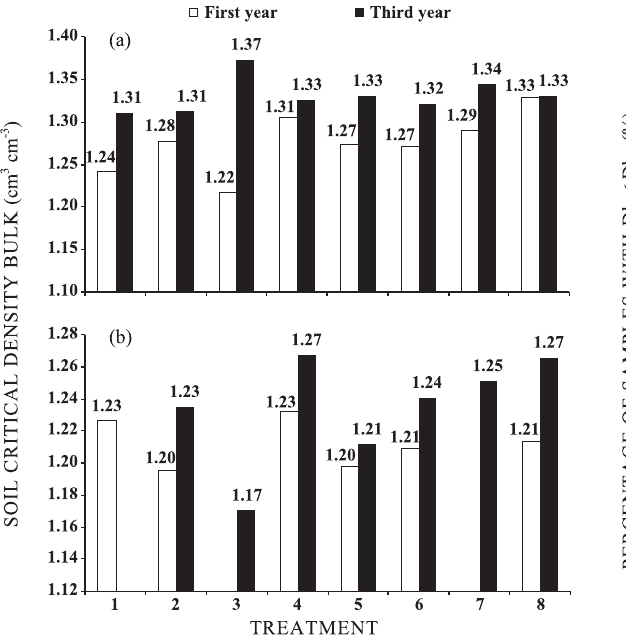
Figure 5. Soil critical bulk densities in the 0–20 (a) and 20–40 cm (b) layers, in the first and third year. Treatments: sunflower+millet (1); sunflower+forage sorghum (2); sunflower+sunn hemp (3); sunflower+chiseling (4); triticale+ millet (5); triticale+forage sorghum (6); triticale+ sunn hemp (7) and triticale+chiseling (8).